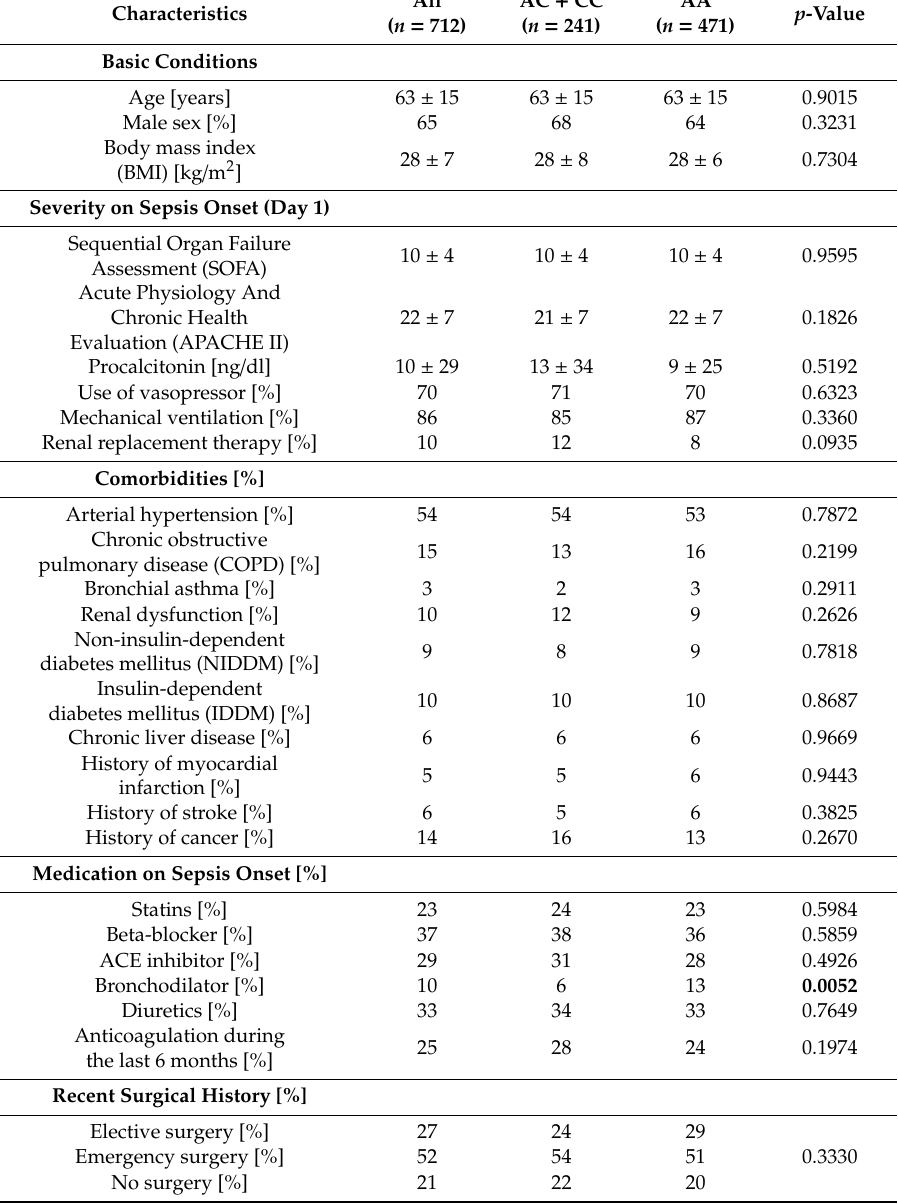
Table 1. Patient baseline characteristics with regard to the TIM-3 rs1036199